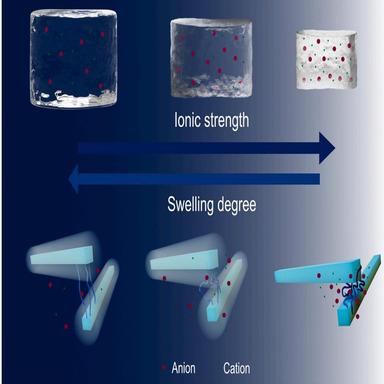
Visual representation of the swelling mechanism for the covalently crosslinked gels. Red and green dots represent anions and cations respectively within the gel. High ionic strength of the medium induces a shrinkage of the network while low ionic strength causes an expansion of the network and a stretch of the polymer crosslinks. (For interpretation of the references to color in this figure legend, the reader is referred to the web version of this article.)